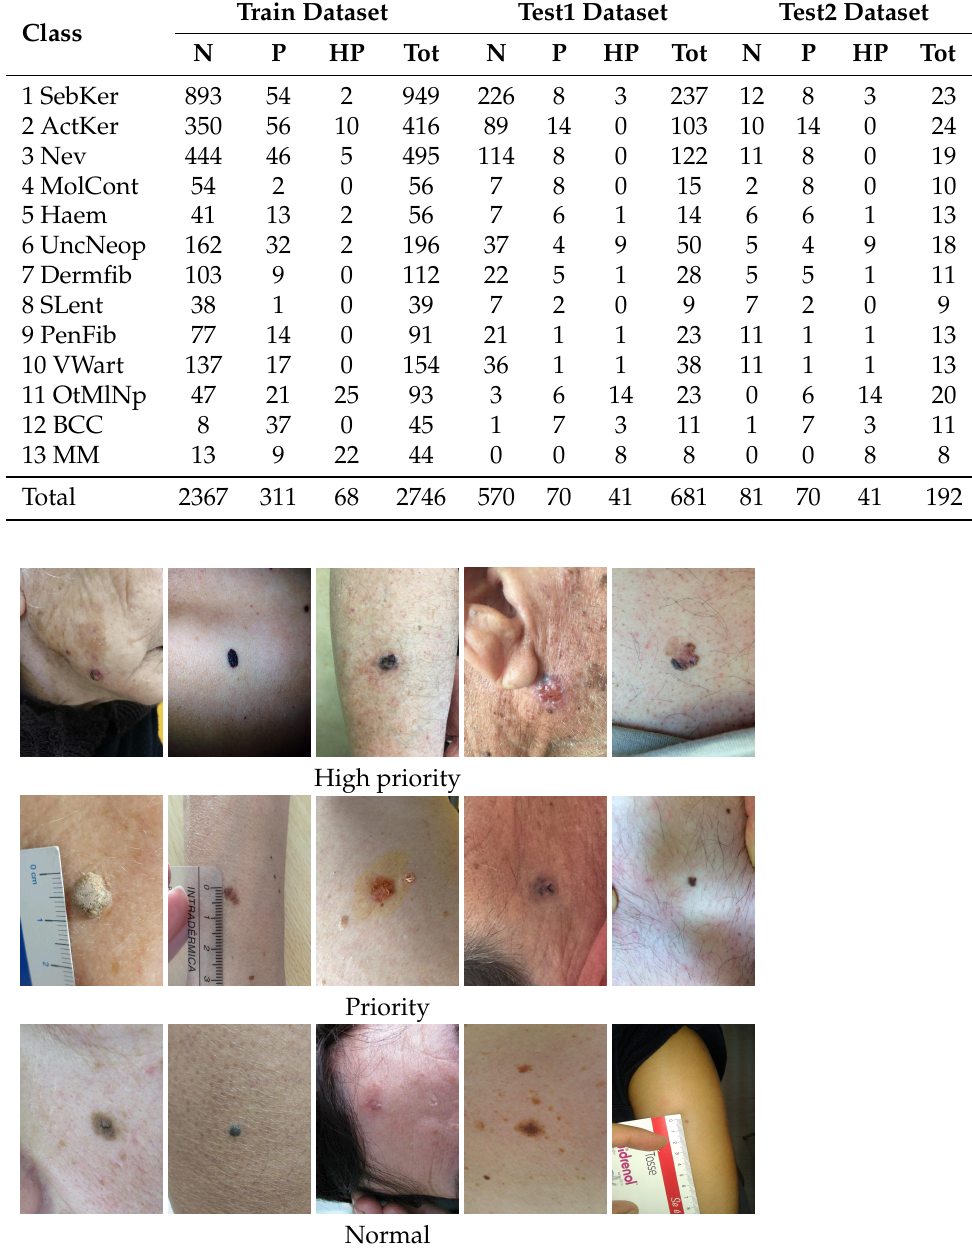
Figure 2. Illustrative examples of lesions from the DermAI dataset with different priority